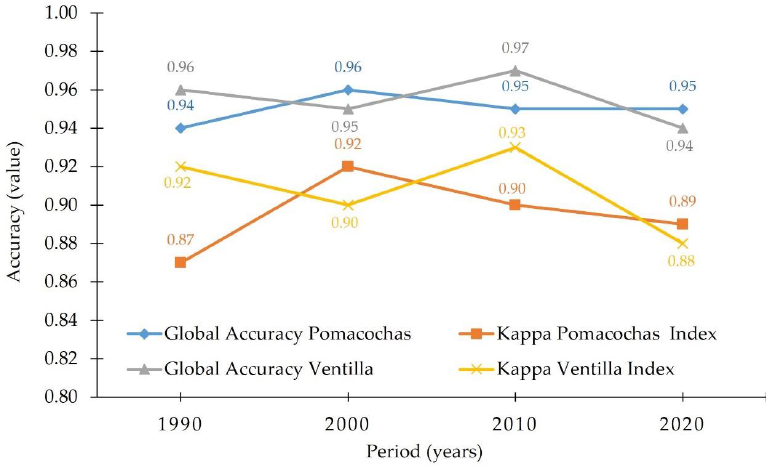
Figure 5. Global precision values and Kappa index for the Pomacochas and Ventilla micro-water- shed.